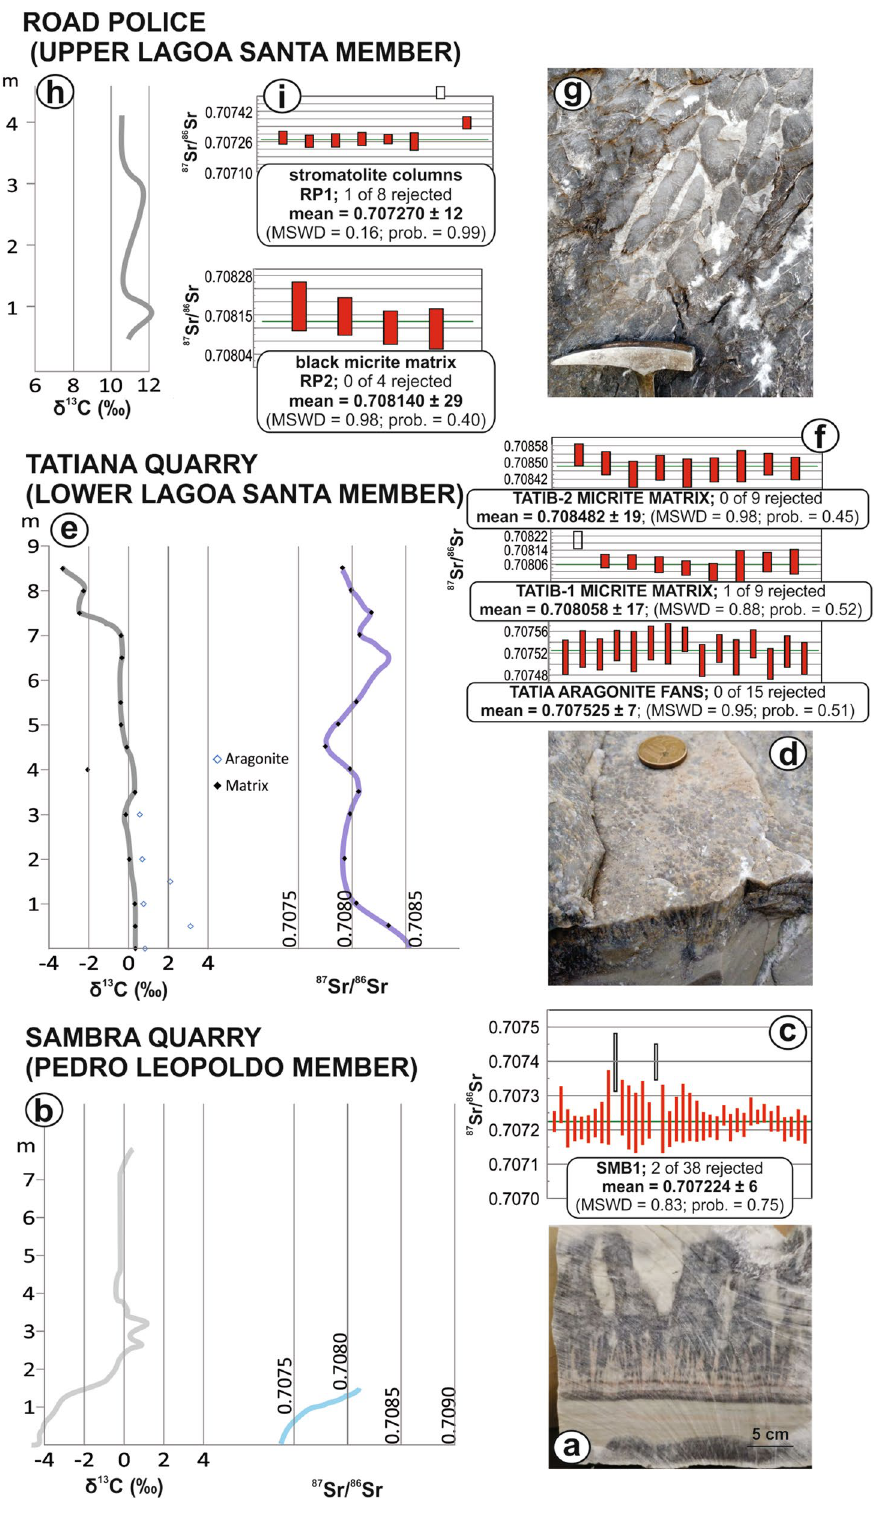
Figure 2. Field pictures and isotopic results of the studied rock samples. Calcite pseudomorphs after aragonite-fan bearing carbonates of the Pedro Leopoldo Member ( a ) with typical cap carbonate δ 13 C carb ( b ) and early Ediacaran 87 Sr/ 86 Sr at ca. 0.7072 ( c ); Calcite pseudomorphs after aragonite-fan bearing carbonates of the Lagoa Santa Member ( d ) with near-zero δ 13 C carb ( e ) and late Ediacaran 87 Sr/ 86 Sr around 0.7080 ( f ); Dark stromatolitic carbonates of the topmost Lagoa Santa Member ( g ) with δ 13 C carb > 10‰ corresponding to the MIBE ( h ) and 87 Sr/ 86 Sr back to values at ca. 0.7072 ( i ). Whole-rock values of δ 13 C carb and 87 Sr/ 86 Sr for the Tatiana Quarry ( e ) and all in-situ 87 Sr/ 86 Sr values are from this work; whole-rock values of δ 13 C carb and 87 Sr/ 86 Sr for the Sambra ( b ) and Road Police ( h